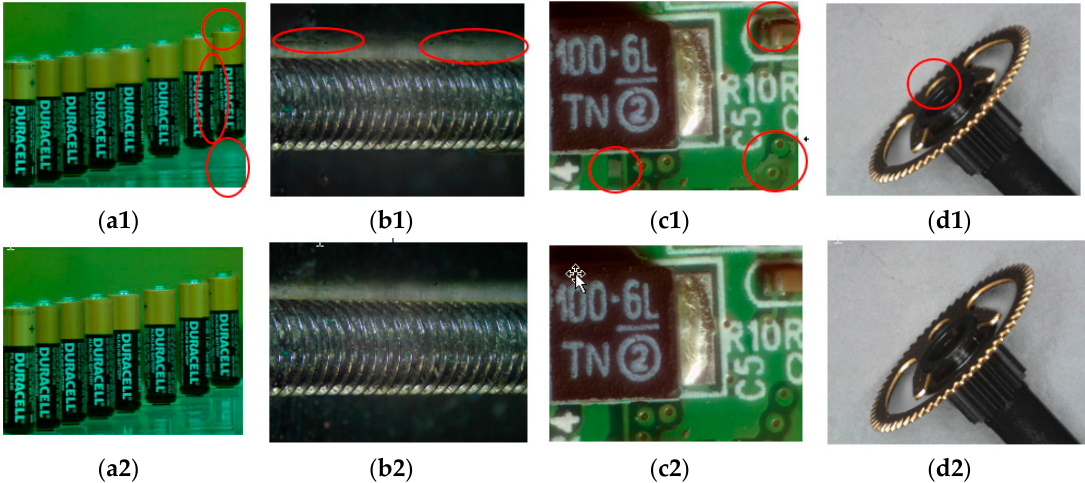
Figure 11. Results of AIF images ( odd rows ) and depth maps ( even rows ) for “Battery”( rows 1–2 ), “Screw” ( rows 3–4 ), “PCB” ( rows 5–6 ), and “Tool” ( rows 7–8 ) obtained by Helicon ( column 1 ), Zerene Stacker ( column 2 ), [12] ( column 3 ), and proposed method ( column 4 ).